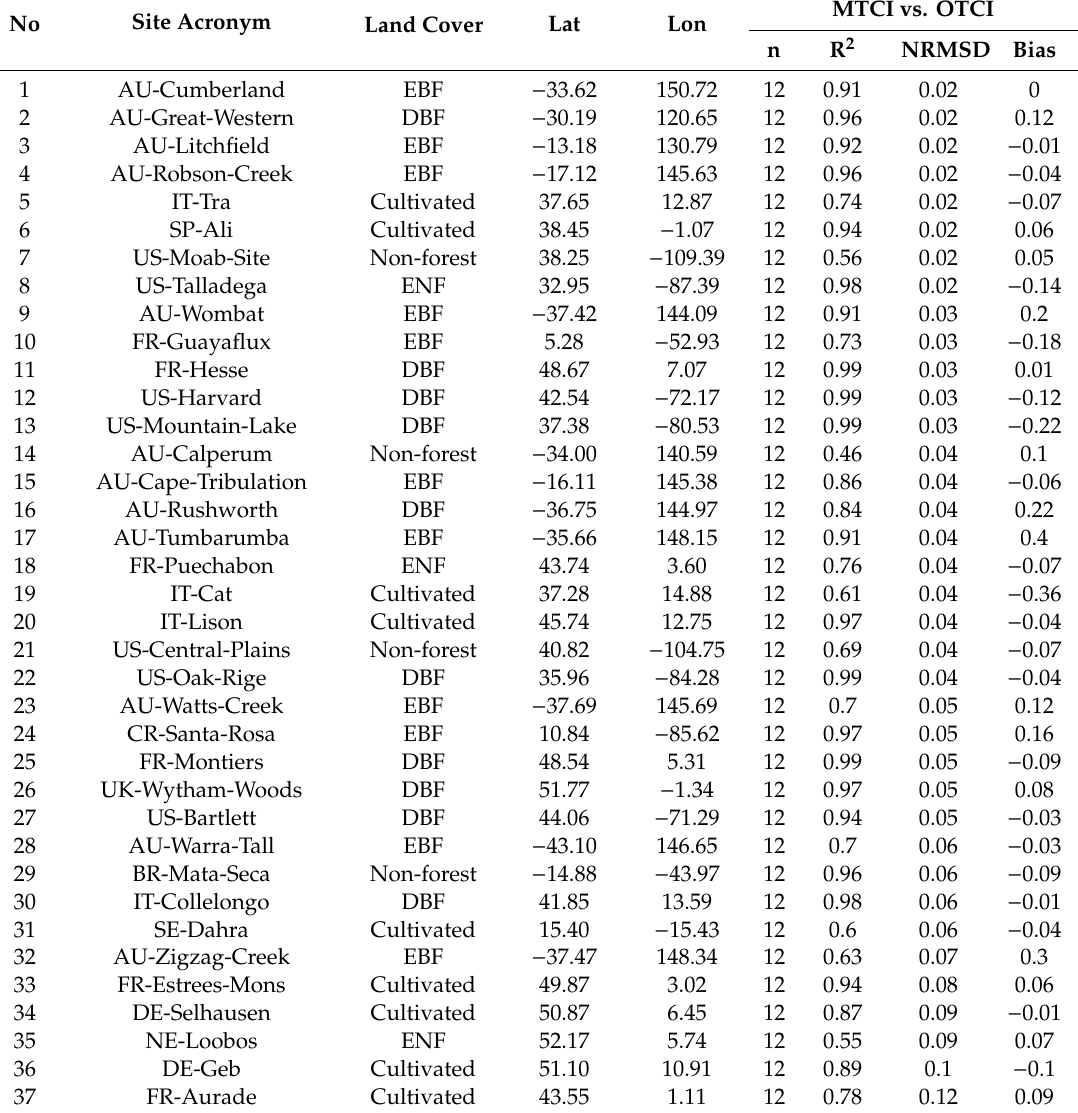
Table 4. Statistics of the comparison between monthly mean Sentinel-3 OTCI (2016 to 2019) and Envisat MTCI (2002 to 2012) values over the considered validation sites. Sites are sorted by the